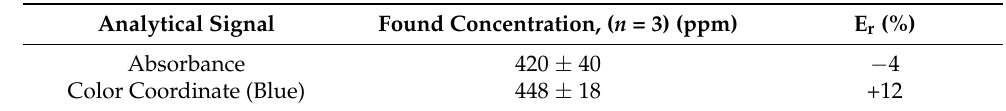
Table 3. Results obtained for sample S2 fortified with 400 ppm of AMP ( n = 3). Analytical Signal Found Concentration, ( n = 3)